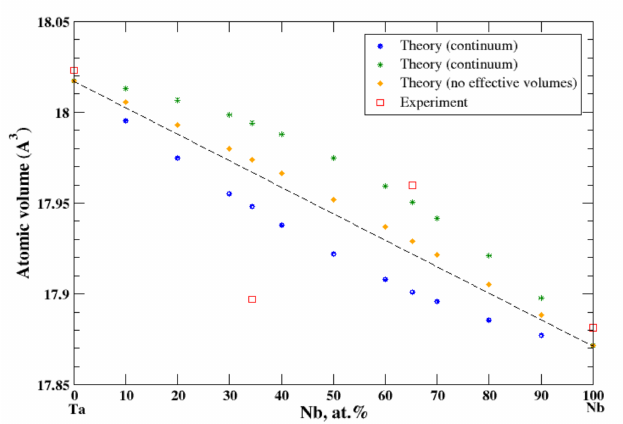
Figure 19. Atomic volume vs. concentration for Nb-Ta alloy system. The experimental data are from Ref. [16] (p. 757 and p.